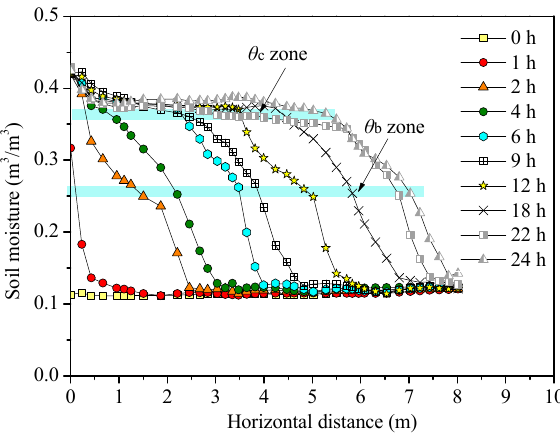
Figure 7. Soil moisture profiles measured by the DMS interrogator. c θ zone is the soil moisture range c θ located in, and b θ zone is the soil moisture range b θ located in.